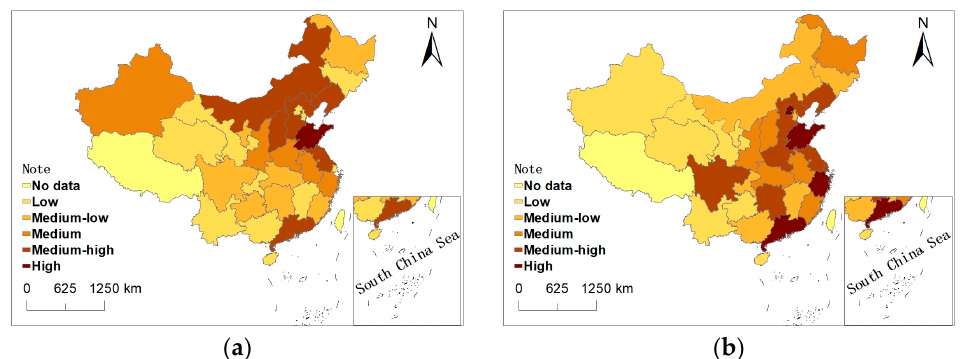
Figure 3. ( a ) Spatial distribution of total carbon emissions in 2018; ( b ) spatial distribution of financial employees in 2018 .